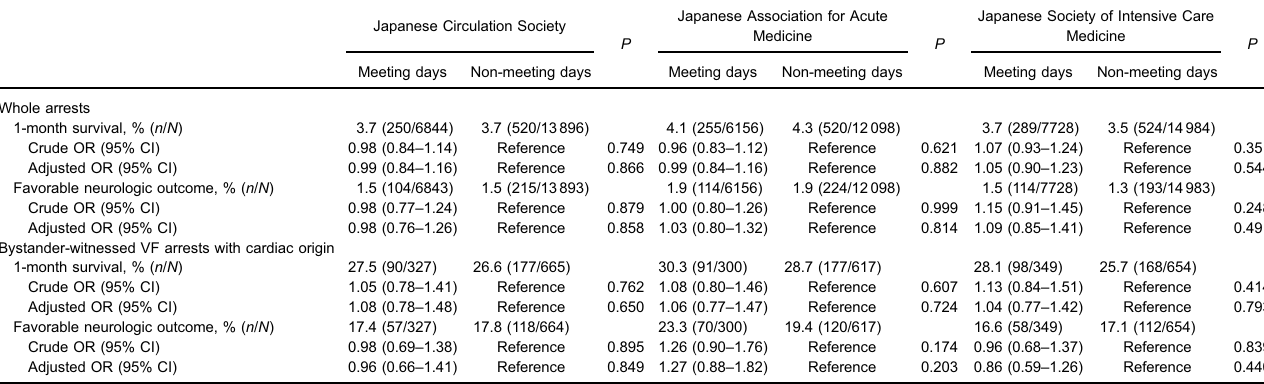
Table 3. Outcomes of out-of-hospital cardiac arrest during meeting and non-meeting days by the type of national meeting